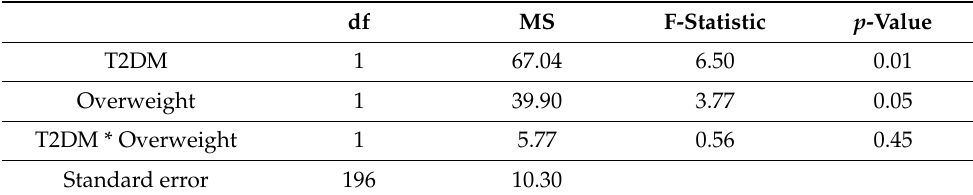
Table 4. Two-way analysis of variance of effects of diabetes, overweight, and their interaction * on global longitudinal strain.